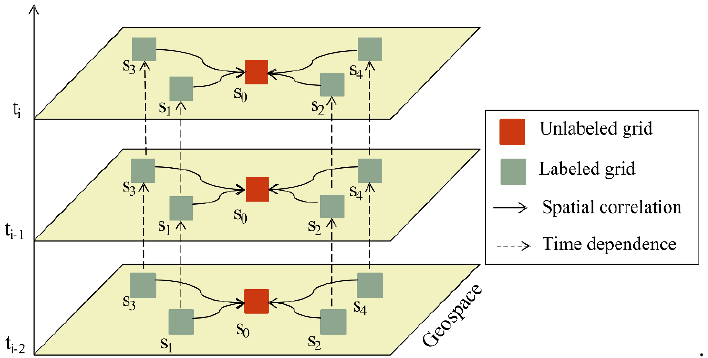
Figure 3. Schematic diagram of calculating the spatiotemporal features of PM 2.5 . The t i , t i-1 , t i-2 represent one hour, two hours, and three hours before the current moment respectively. The labeled grids (s 1 , s 2 , s 3 , s 4 ) represent the places that include ground monitoring stations, while the unlabeled grid (s 0 ) represents the space that needs to be estimated.